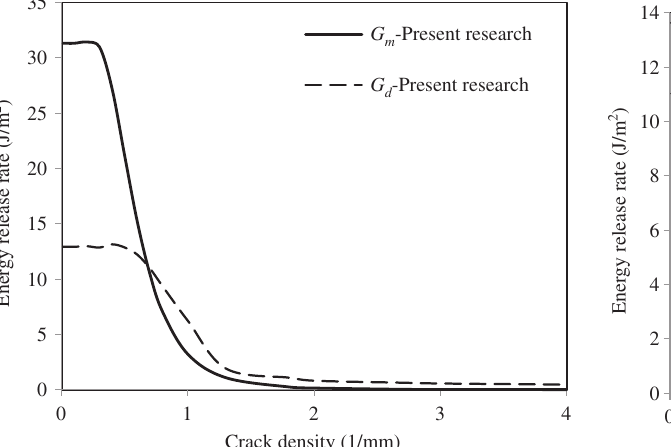
] s carbon/ Figure 10: Crack density vs. energy release rate for [0/90 3